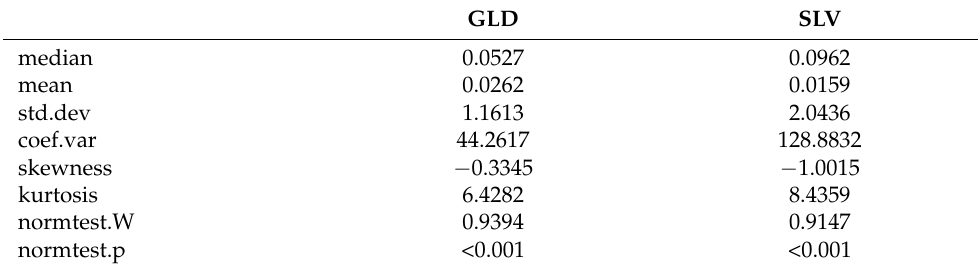
Table 1. Descriptive statistics of daily